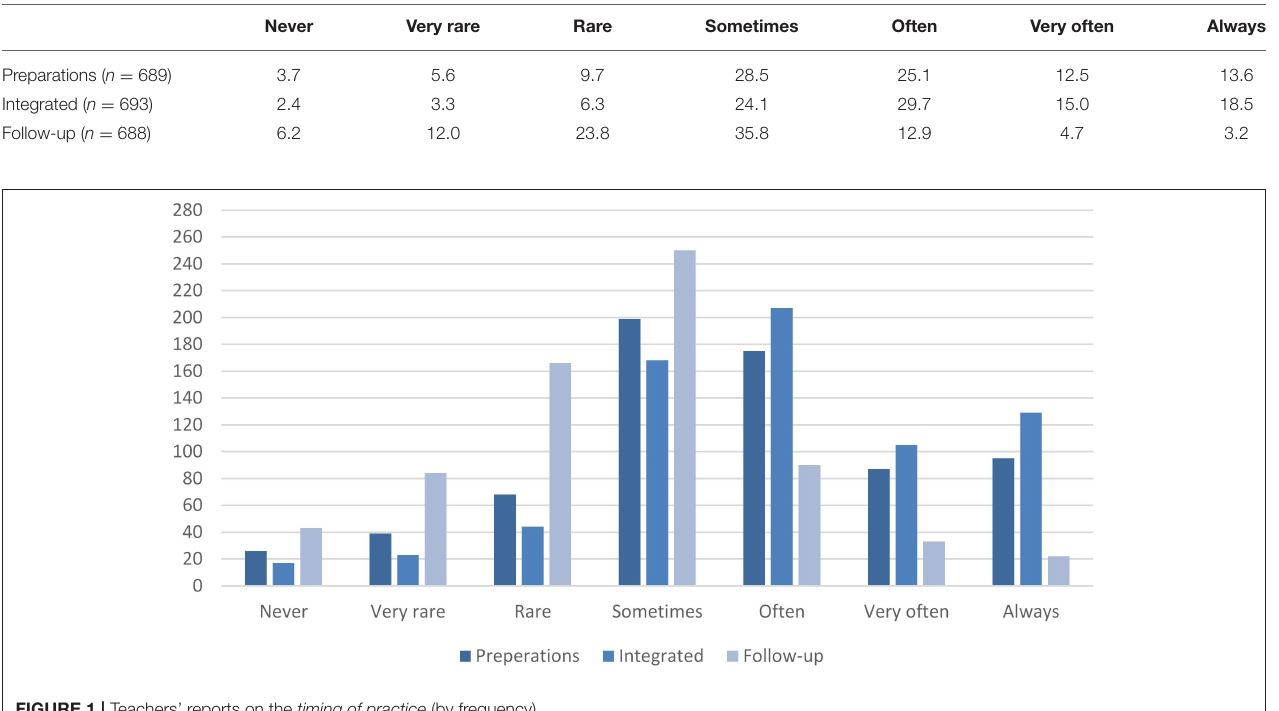
TABLE 4 | Teachers’ report on how often RSM is part of the preparations, integrated in teaching, and in the follow-up of PE classes (by percent).